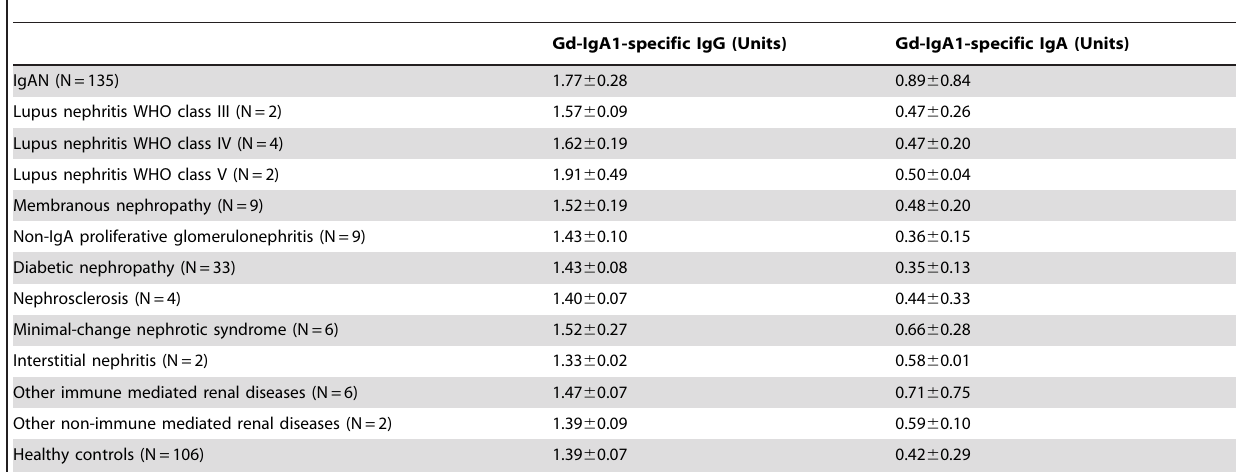
Table 3. Serum levels of Gd-IgA1-specific antibodies in patients with IgAN, CKD controls and healthy